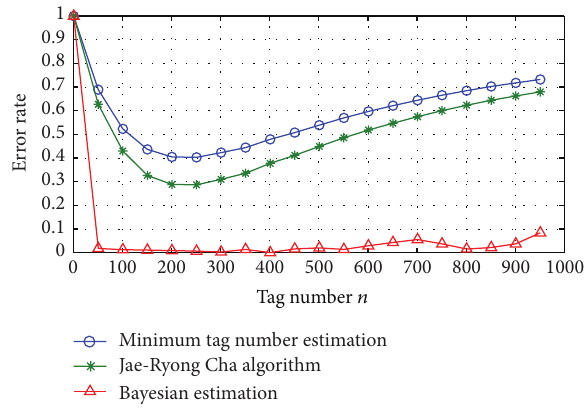
Figure 3: Comparison of error rate for algorithms.